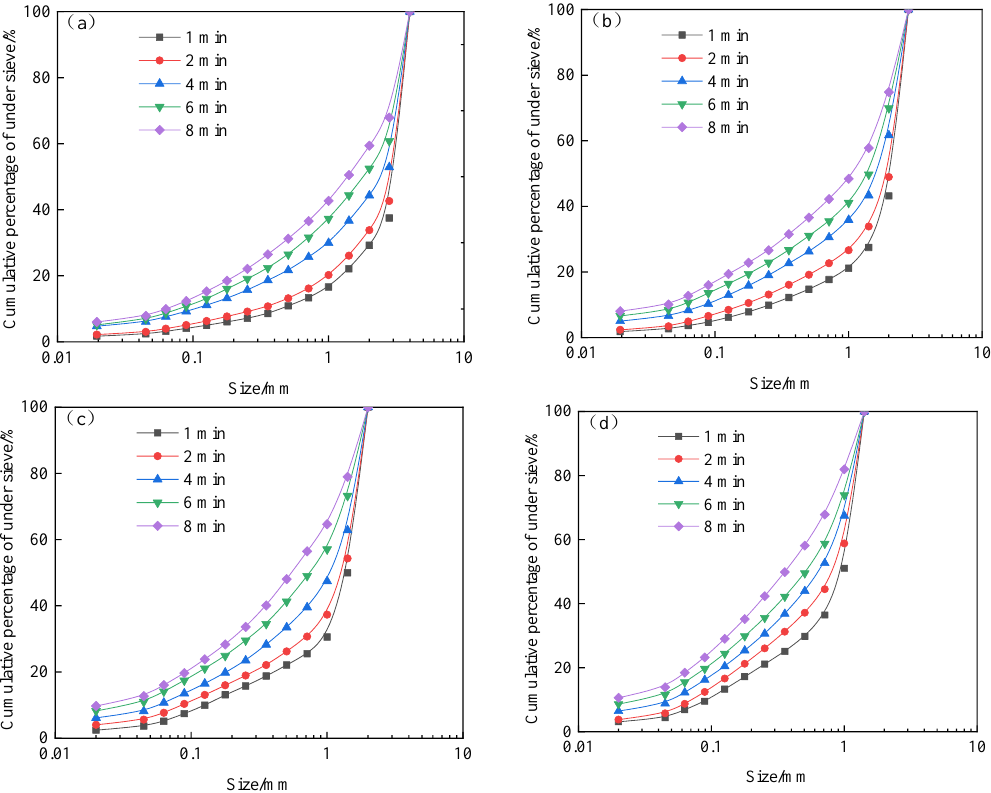
Figure 1. Particle size distribution of grinding products for complex polymetallic ores (( a ): −4.75 + 3.35 mm, ( b ): −3.35 + 2.36 mm, ( c ): −2.36 + 1.70 mm, ( d ): −1.70 + 1.18 mm). (( a ): − 4.75 + 3.35 mm, ( b ): − 3.35 + 2.36 mm, ( c ): − 2.36 + 1.70 mm, ( d ): − 1.70 + 1.18